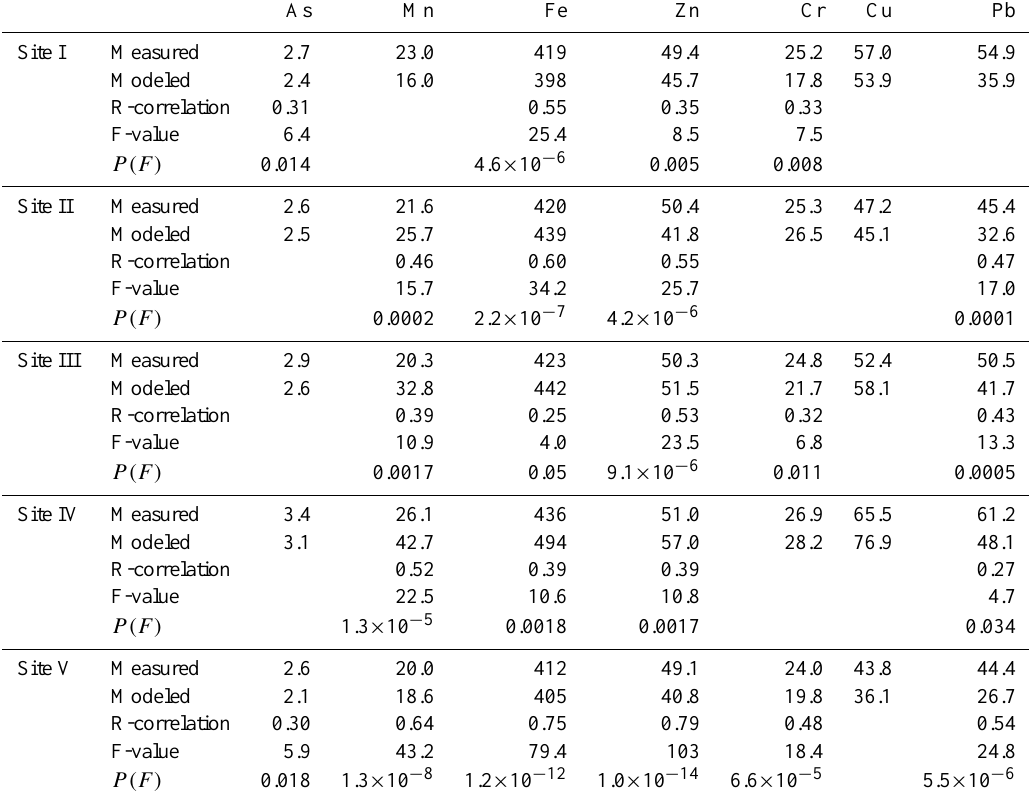
Table 4. Measured and modeled annual dry deposition fluxes (µgm − 2 day − 1 ) and the regression analysis between modeled and measured